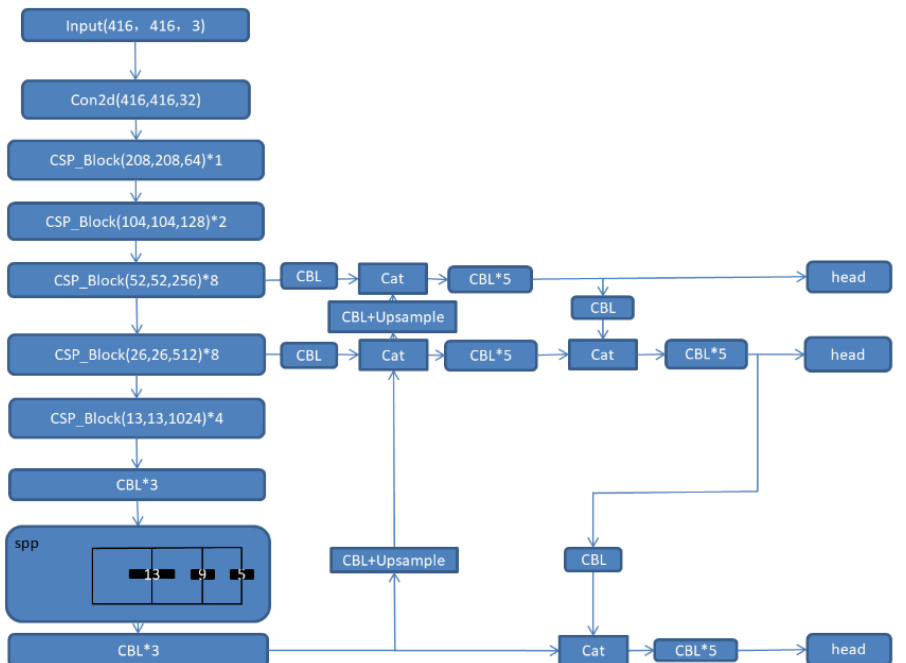
Figure 2. Block diagram of YOLOv4.